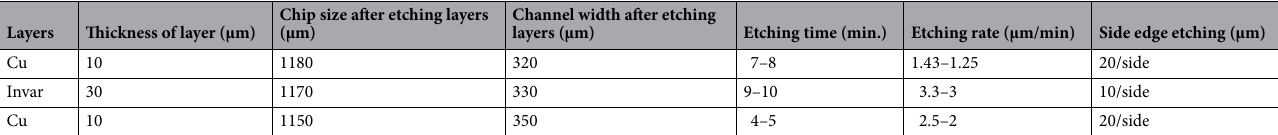
Table 1. Summary of the etching layers during the dicing